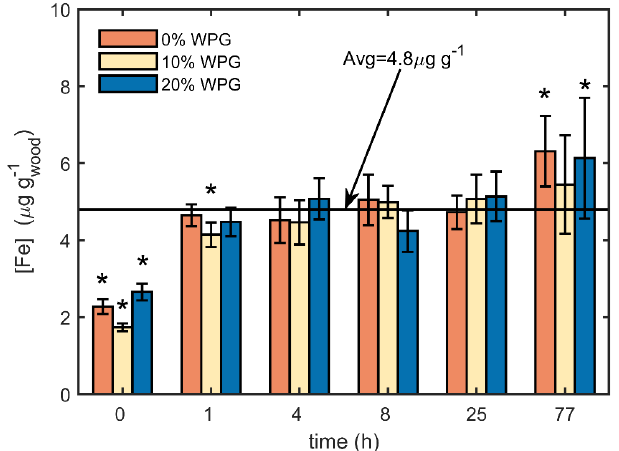
Figure 2. Concentration of iron in wood sections soaked in a 100 µM iron + 1 mM oxalate solution as a function of the level of acetylation and time in solution. Error bars represent the 95% confidence interval. * indicates that a data set is significantly different ( p < 0.05) from the grand average of 4.8 µg g −1 .